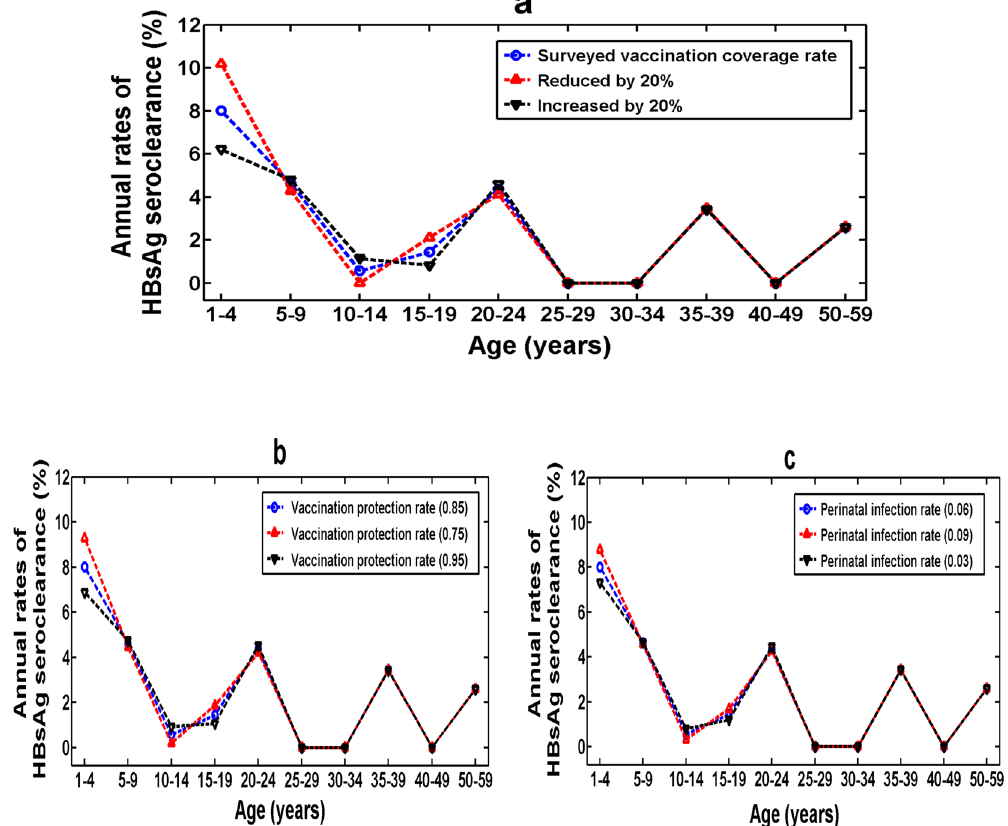
Figure 4. The influence of parameters on estimation of annual rate of HBsAg seroclearance. ( a ) The influence of vaccination coverage rate for newborns. ( b ) The influence of vaccination protection rate. ( c ) The influence of perinatal infection